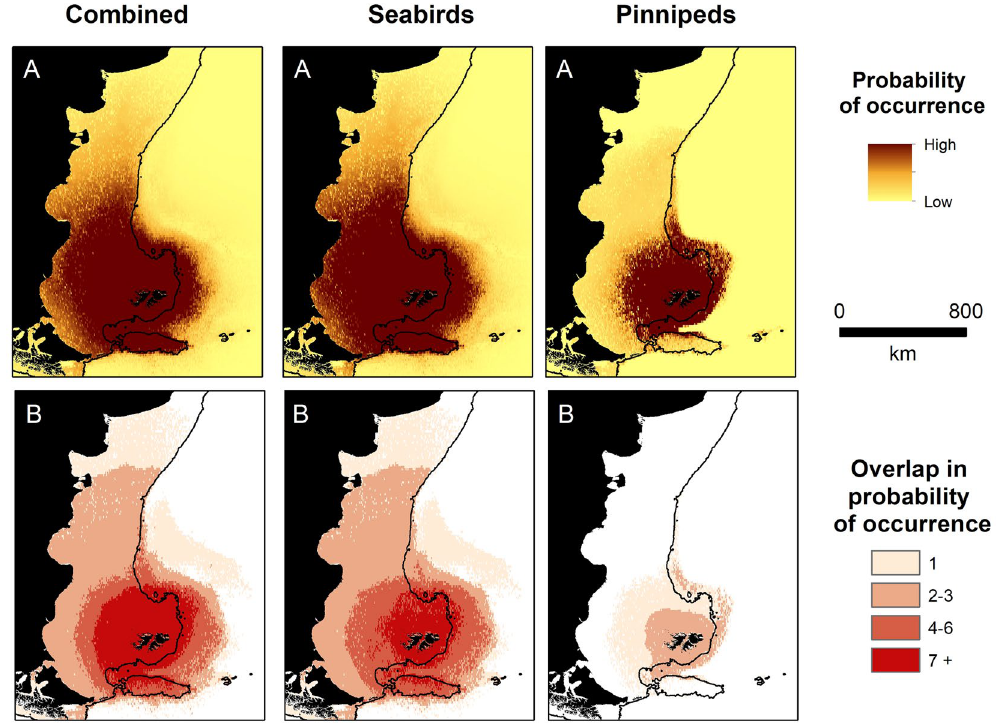
Figure 4. Combined species plots of ( A ) cumulative probability of occurrence ( B ) overlap in probability of occurrence between groups (see Table 2 and Figs 2 and 3 for details of predictive models) and for seabirds and pinnipeds separately.